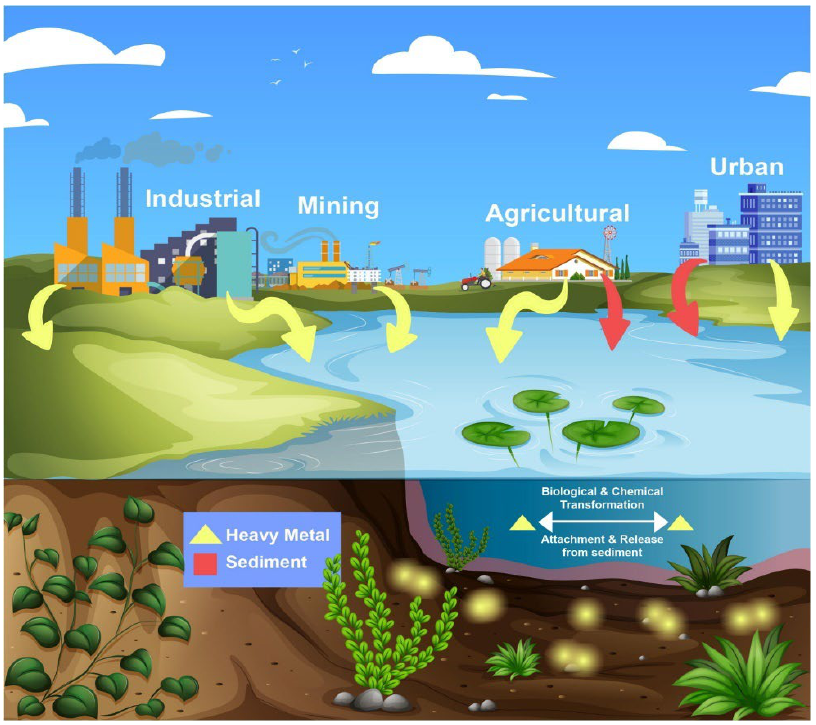
Figure 4. Graphical representation of heavy metals in the environment [59]. Reproduced from Saikat Mitra et al., 2022 (ref. [59]). Copyright 1969, Elsevier.